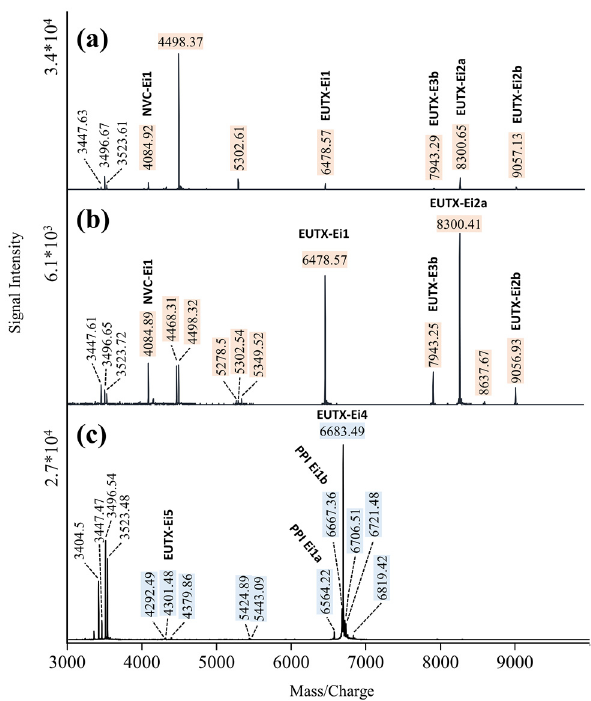
Figure 3. Comparison of MALDI-TOF mass fingerprints (m/z 3000–10,000) of venom extracted from juvenile ( a ), female ( b ), and male E. italicus ( c ). Male-specific ion signals are highlighted in blue; ion signals that are missing in mass spectra of venom from males are highlighted in beige.